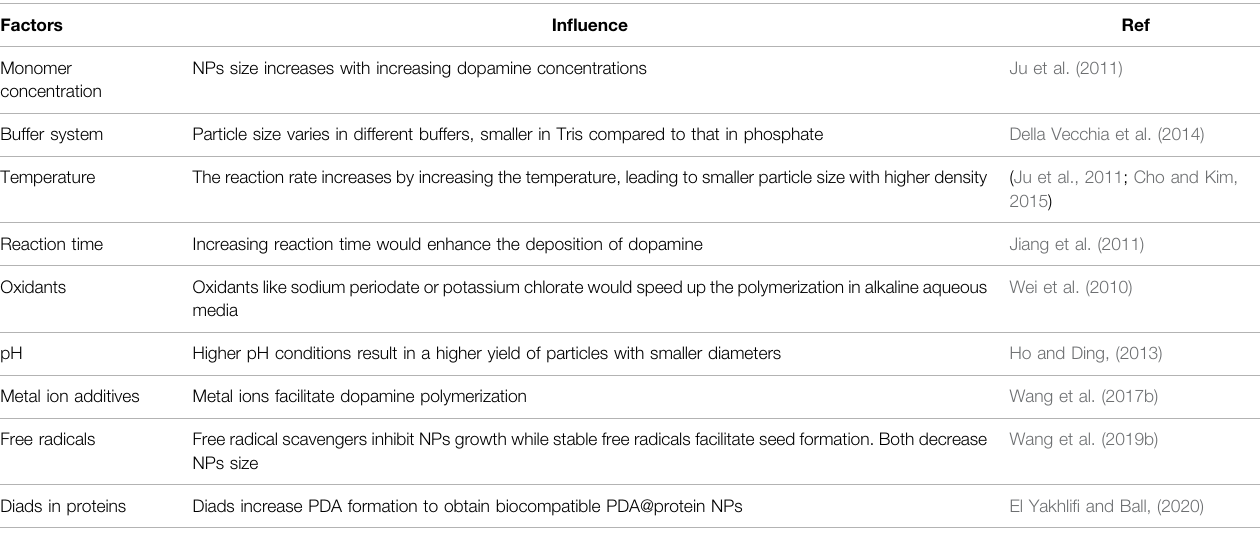
TABLE 1 | Factors in fl uencing the synthesis of PDA-NPs.